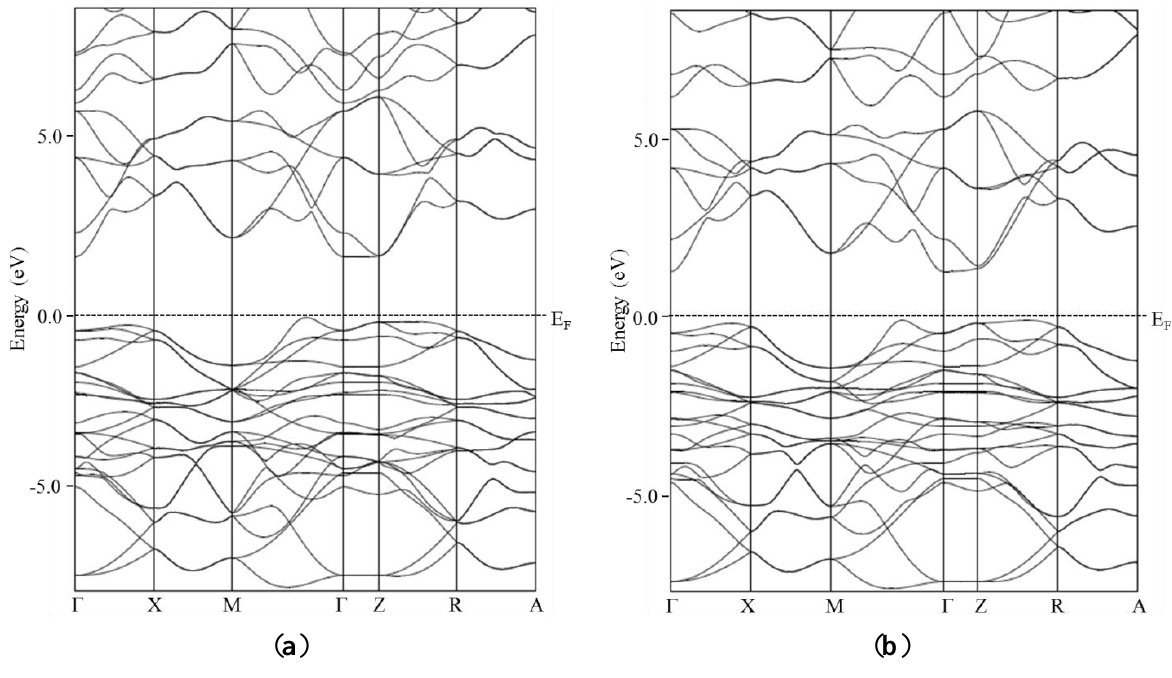
Figure 5. Electronic band structure close to the Fermi level of BiCuSO ( a ) and BiCuSeO ( b